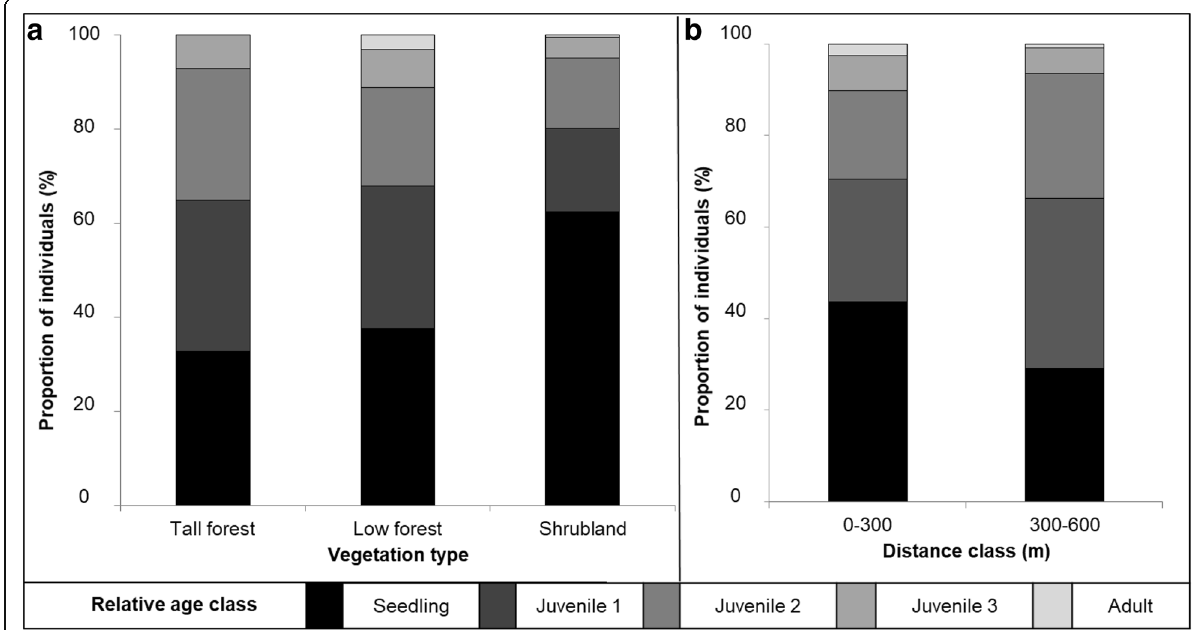
Fig. 4 Proportion of the relative age classes in each vegetation type and distance class. a Proportion of relative age classes in each vegetation type. b Proportion of relative age classes in each distance